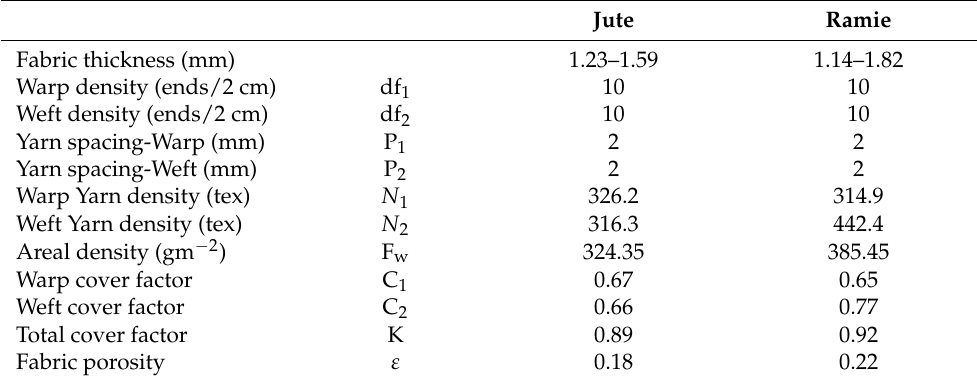
Table 1. Design of hybrid jute–ramie reinforced unsaturated polyester composite.